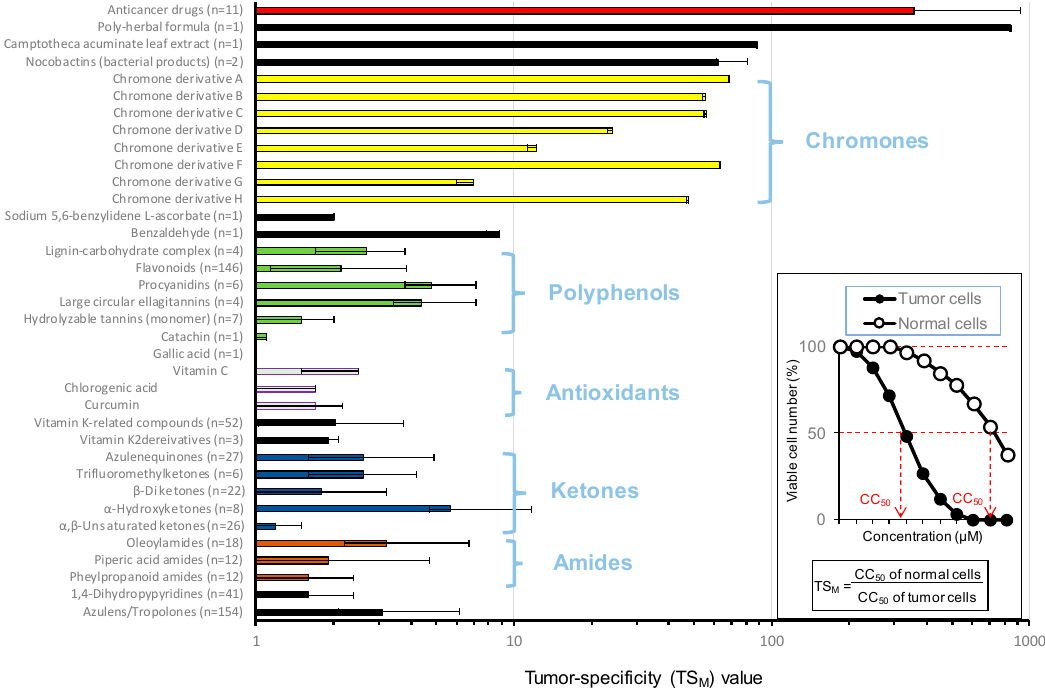
Figure 3. Chromone derivatives showed higher tumor-specificity (TS M ) value than most of the polyphenols. TS M was determined by the following equation: TS M = (mean CC 50 for human OSCC cell lines /mean CC 50 for human normal oral mesenchymal cells. Tumor and normal cells in the insert represent human OSCC cell lines and human normal oral mesenchymal cells. Data of chromones [30,32–38] and other compounds [4] were cited with permission. n, number of compounds tested.